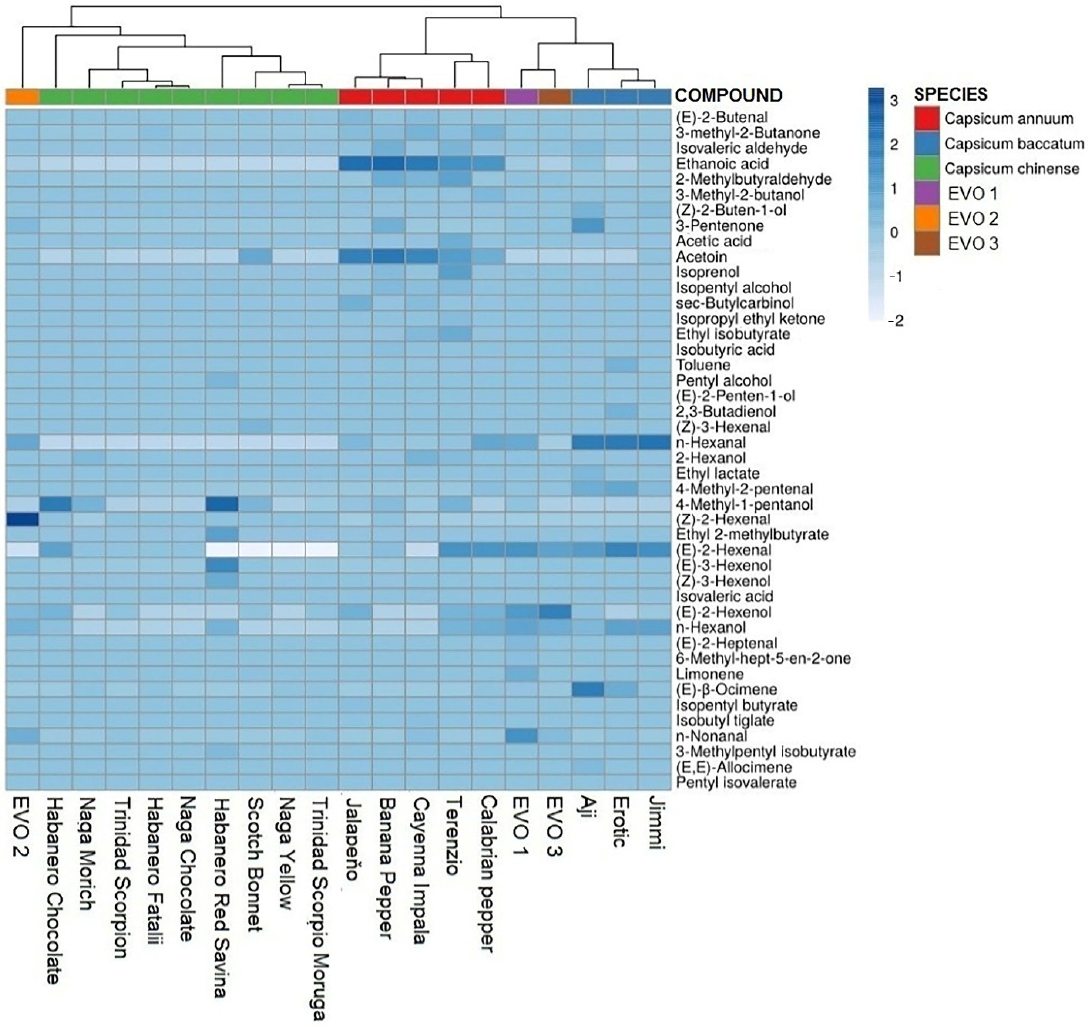
Figure 6. Hierarchical cluster analysis based on relative percentage areas of the 118 most abundant identified volatiles. Original values are ln(x + 1)-transformed. Rows are centered; Pareto scaling is applied to rows. Imputation is used for missing value estimation. Columns are clustered using correlation distance and average linkage. There is a total of 44 rows and 20 columns.